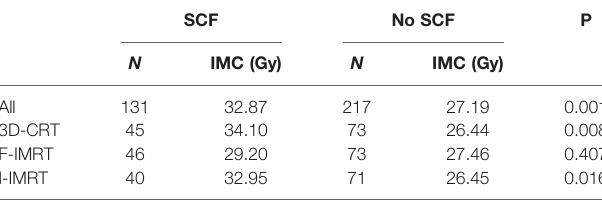
TABLE 3 | Comparison of the mean dose in IMC with SCF versus without SCF.